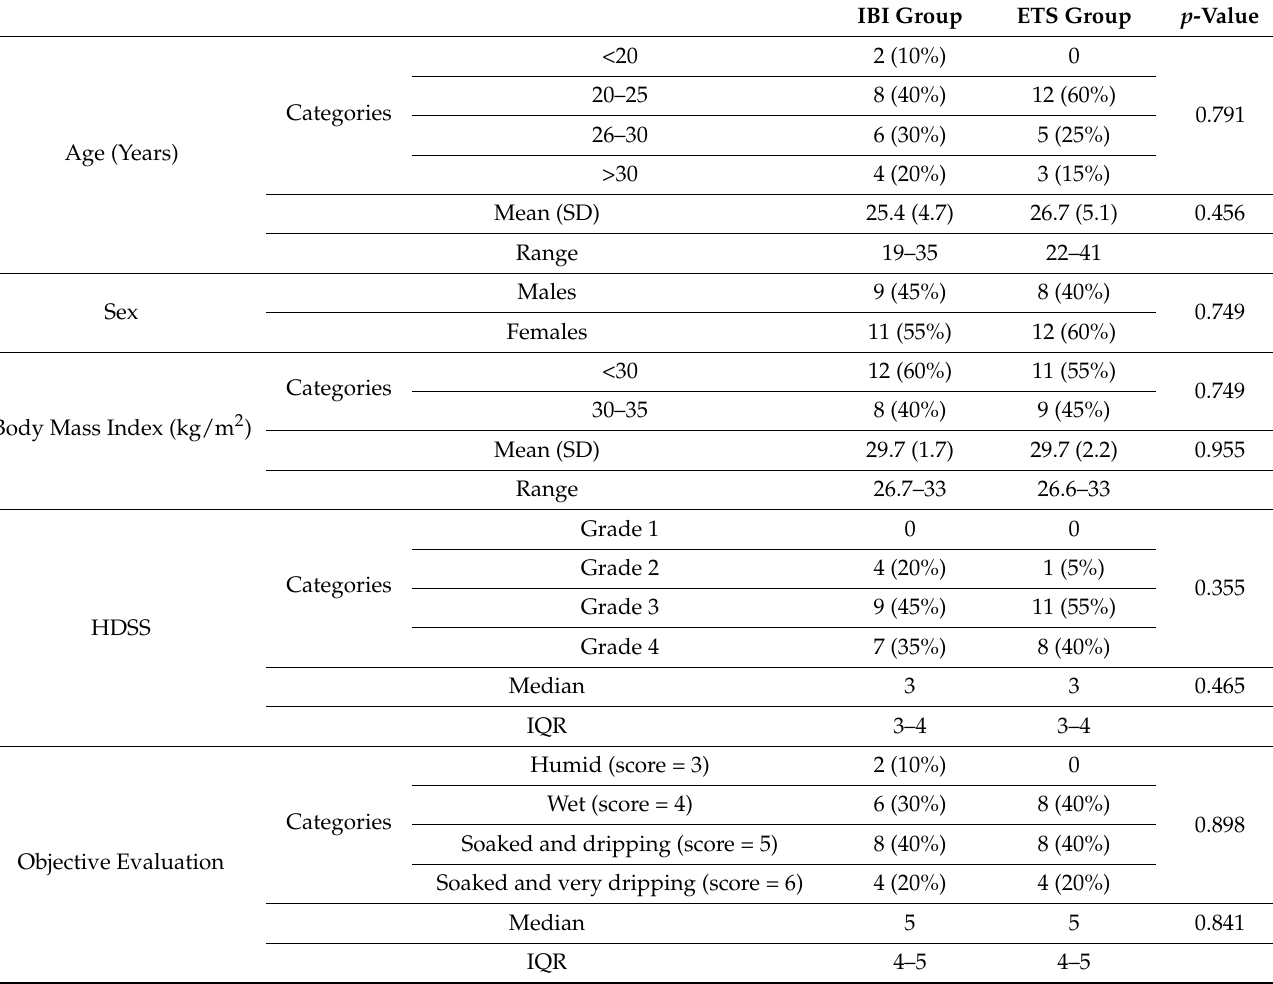
Table 1. Patients’ demographic and clinical data.